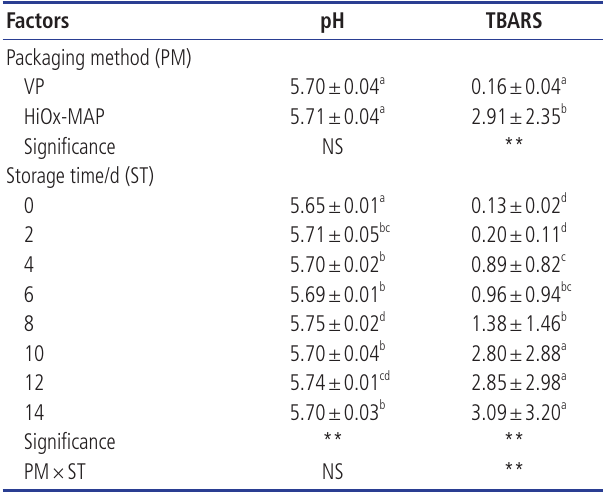
+20% CO ) on pH and TBARS values 2 2